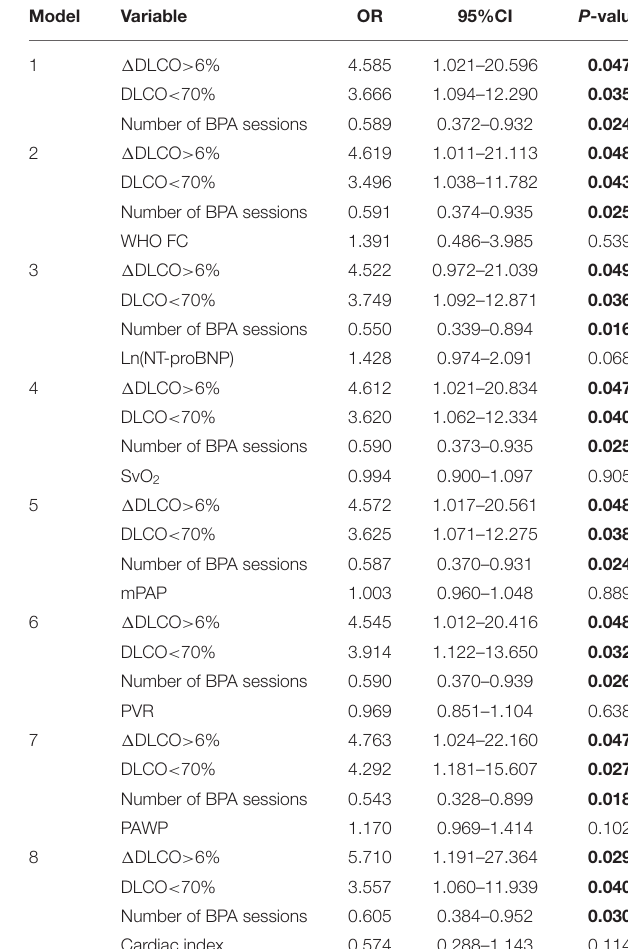
TABLE 4 | Univariate logistic regression analyses for poor hemodynamic response to BPA.